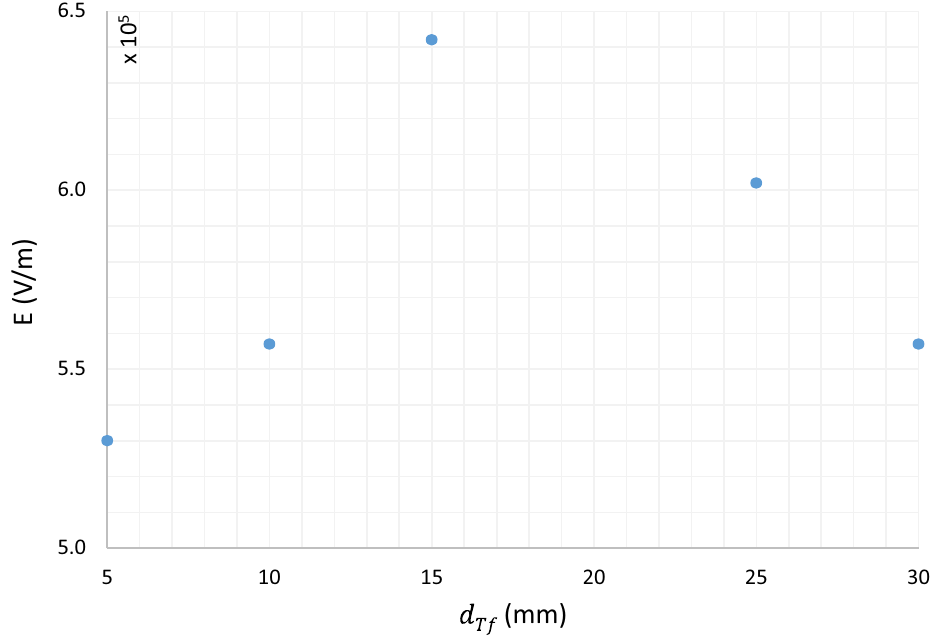
Figure 3. JDBD electric field of the insulating parameter.